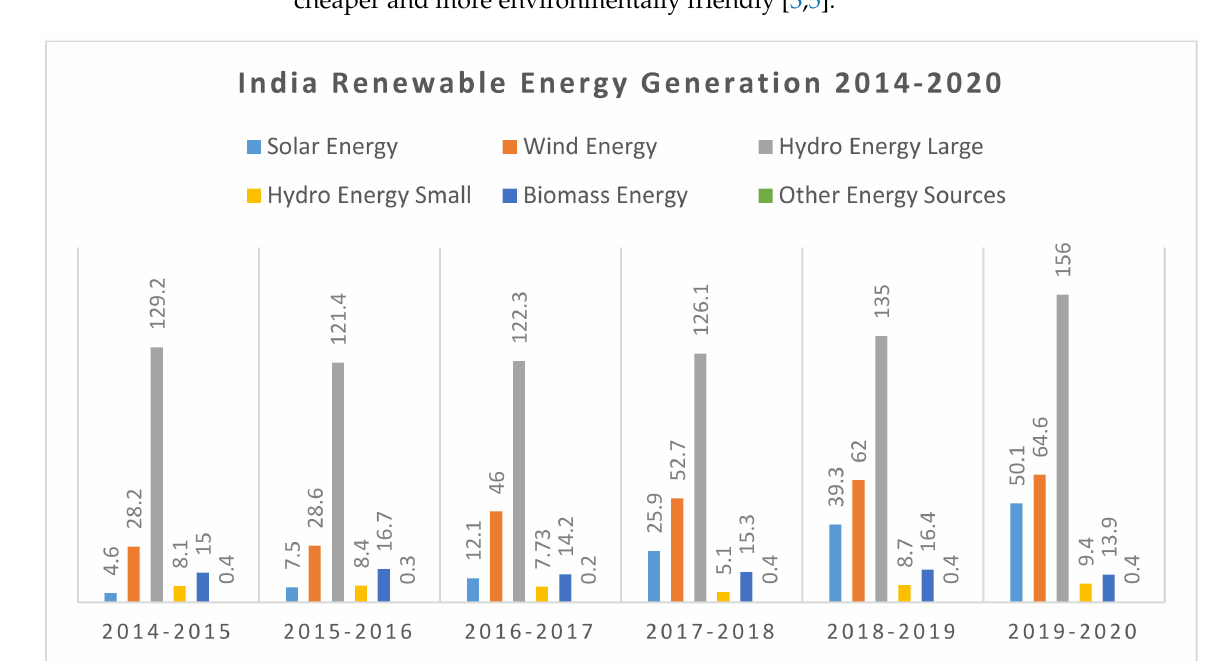
Figure 1. India Renewable energy generation